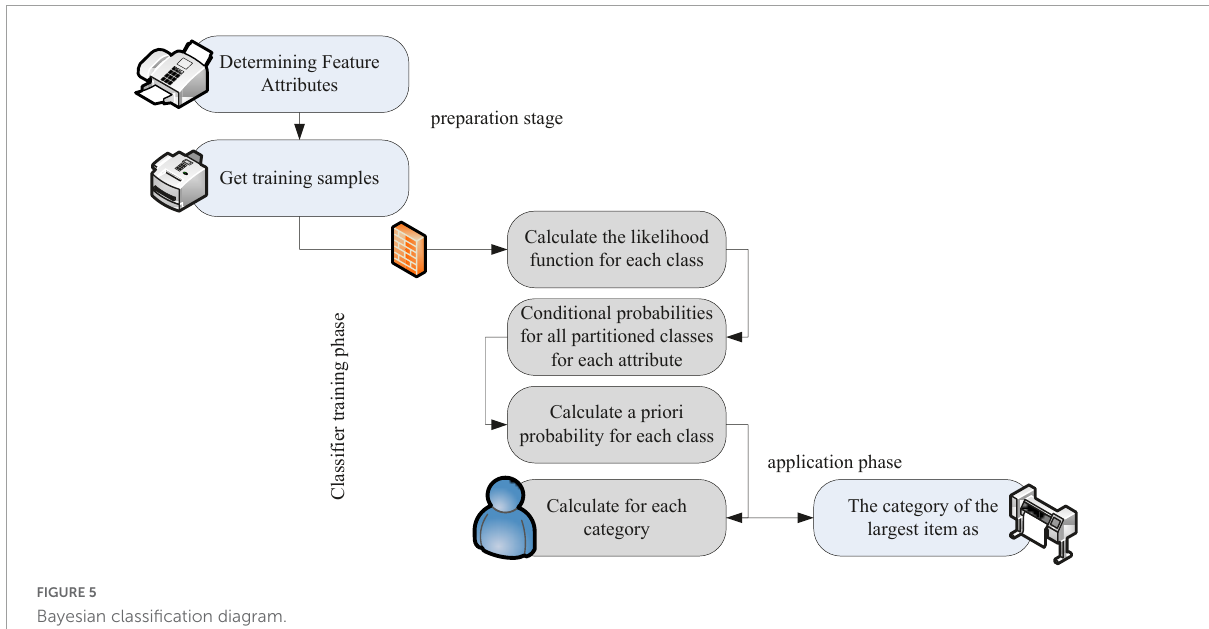
FIGURE5 Bayesian classification